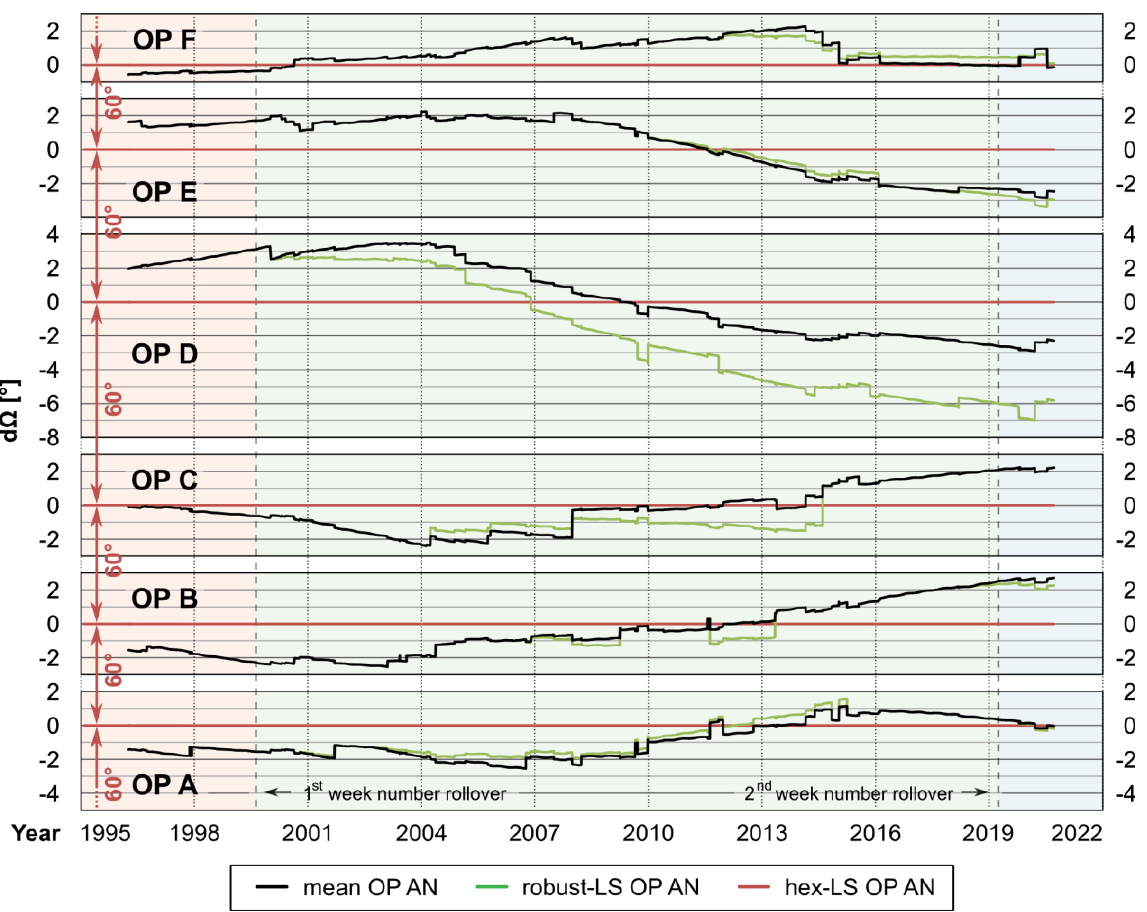
Figure 9. Deviations of OP AN position estimators in relation to the hexagonal symmetry reference.